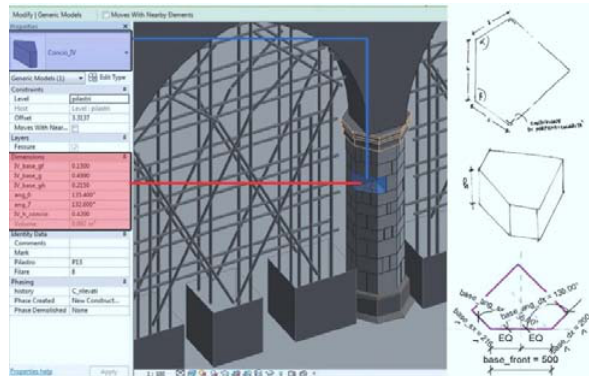
Figure 7. HBM of octagonal stone pillar n. 6 of the nave. On the right the hands on survey of the only ashlar completely visible.